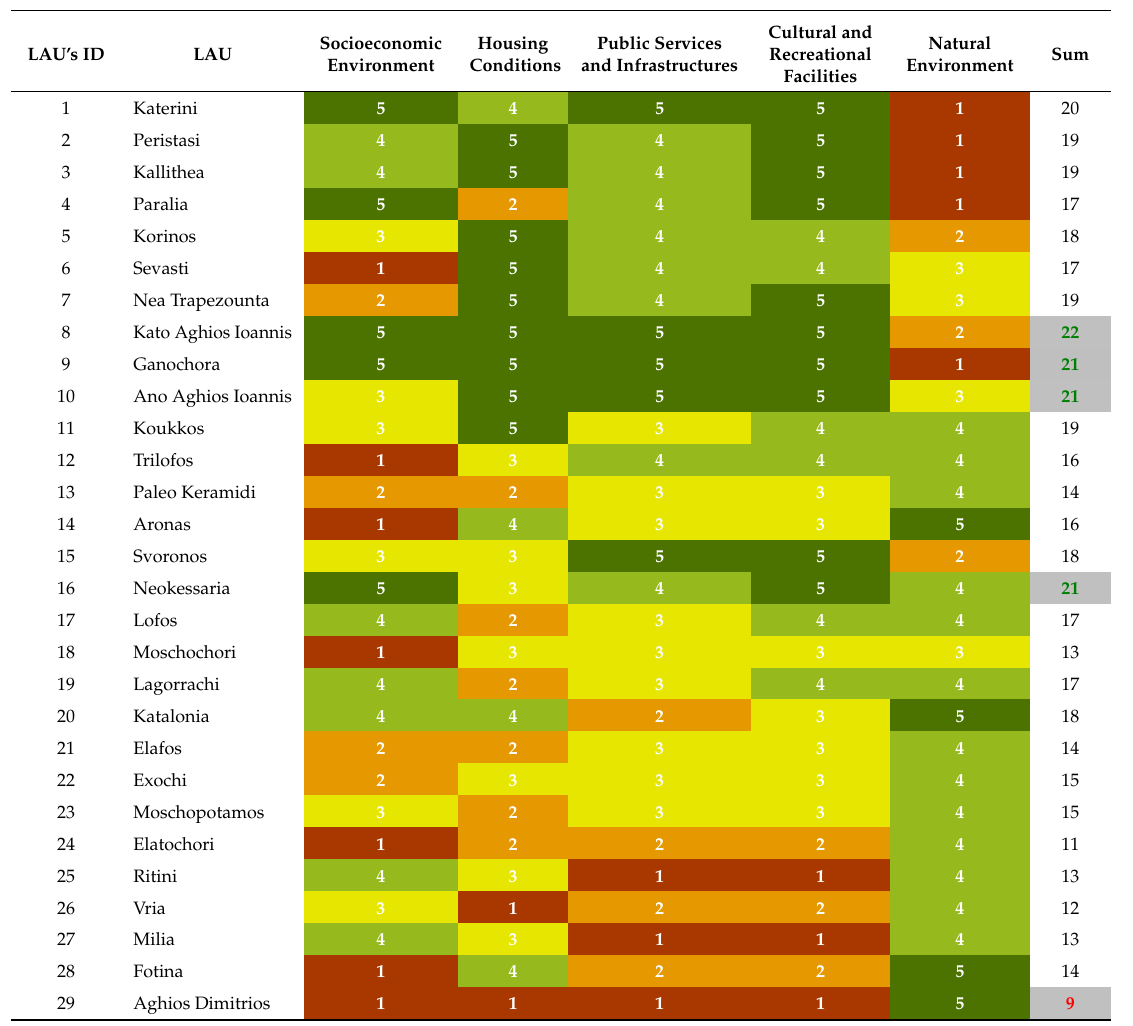
Table 5. LAU scores per